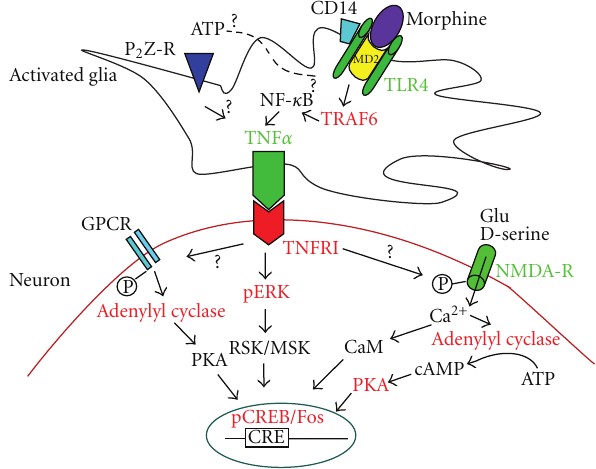
Figure 1: Possible cellular/molecular mechanisms of glia-to- neuron interaction in the PAG in morphine withdrawal. Morphine binds to MD-2 and induces TLR4 oligomerization on the glial cell network to induce synthesis of TNF α through possible TRAF6 and NF- κ B pathways, and so forth. Glial TNF α binds the TNFRI on the neurons to induce the phosphorylation of ERK, further the phosphorylation of CREB. TNFRI signal may induce phosphory- lation (P) of NMDA receptor to increase Ca 2+ influx. This increase in intracellular Ca 2+ leads to several downstream e ff ects including activation of CaM, adenylyl cyclase, cAMP, and further activation of PKA and changes of gene expression (CREB and Fos). GPCR may be activated to induce adenylyl cyclase and PKA activation and to increase gene transcription (CREB and Fos). GPCR: G-protein coupled receptor; glu: glutamate; CaM: calmodulin; NMDA-R: N- methyl-D-aspartate